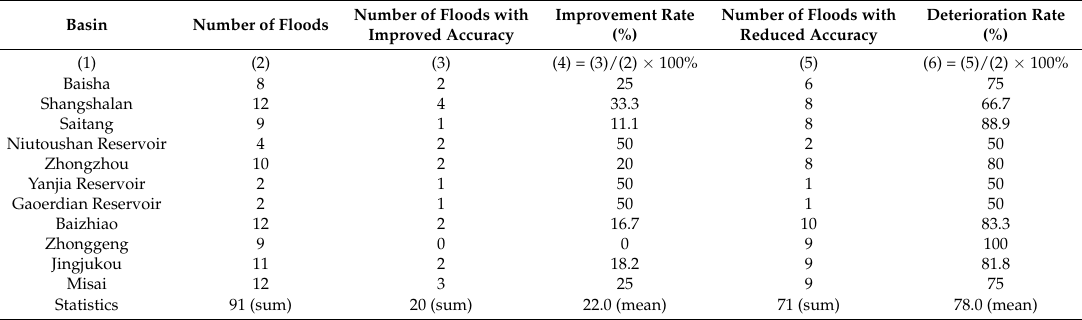
Figure 11. Accuracy improved and deteriorated floods of over-estimated floods.